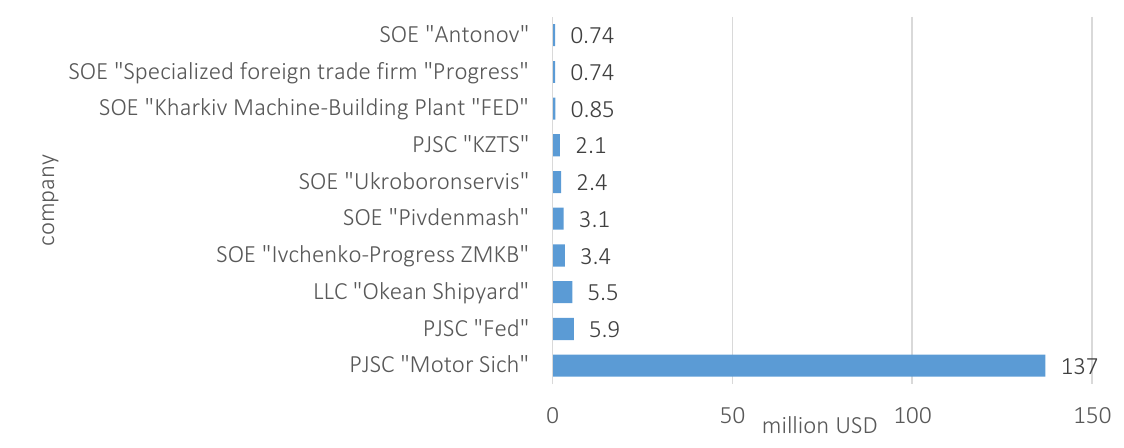
Figure 7. Top 10 Ukrainian companies-exporters of military products in 2020, in terms of